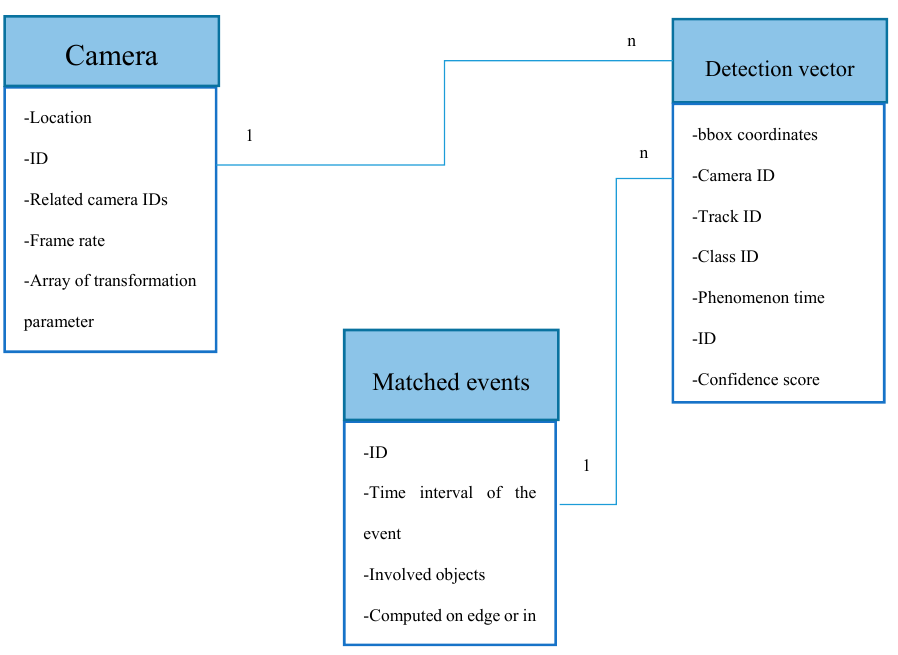
Figure 5. Logical model for the cloud database.